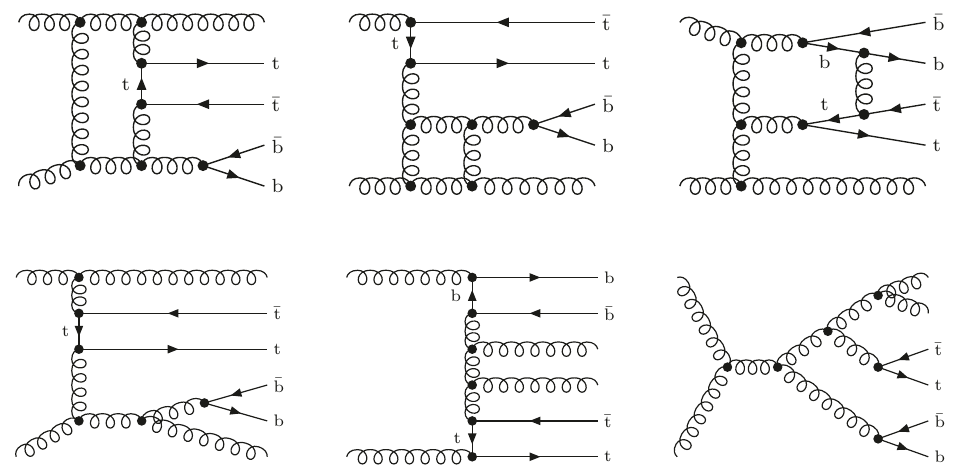
Figure 2. Selected gg diagrams (second